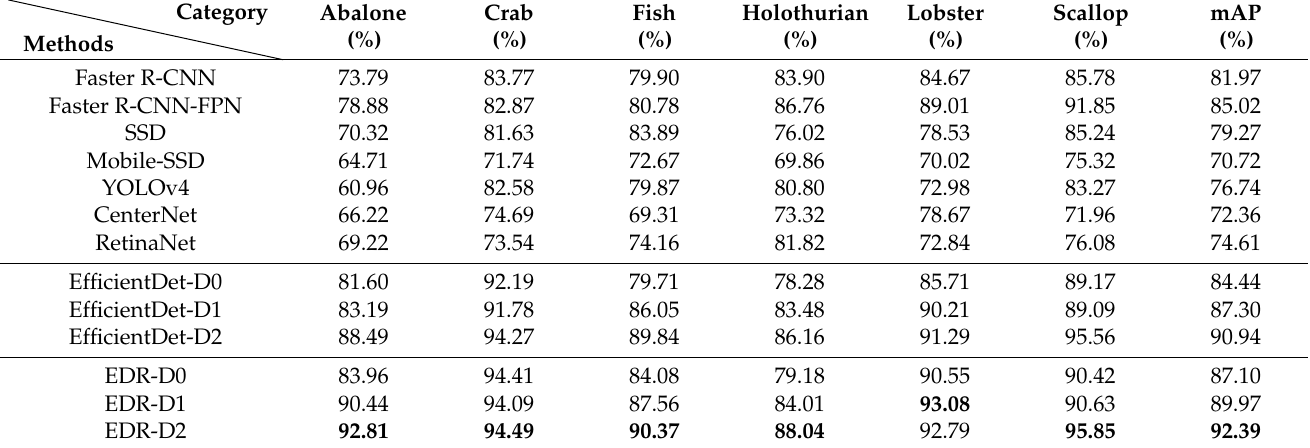
Table 4. The results of different categories between different models on homemade